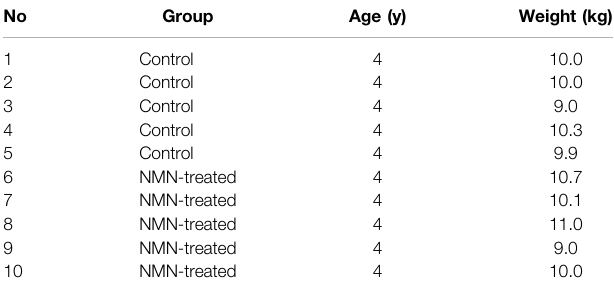
TABLE 1 | The age, weight and groups of beagle